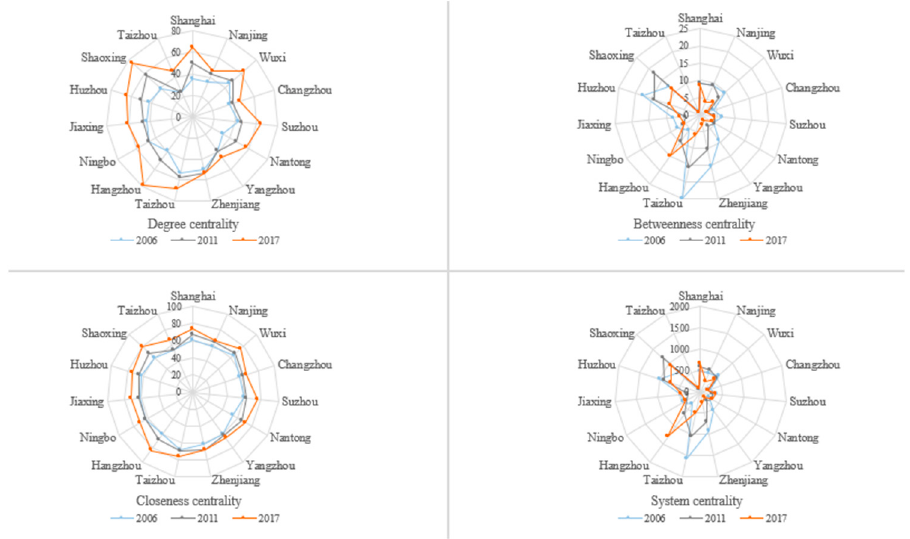
Figure 6. Individual centrality of the water environment governance network of Yangtze River Delta in 2006–2017.